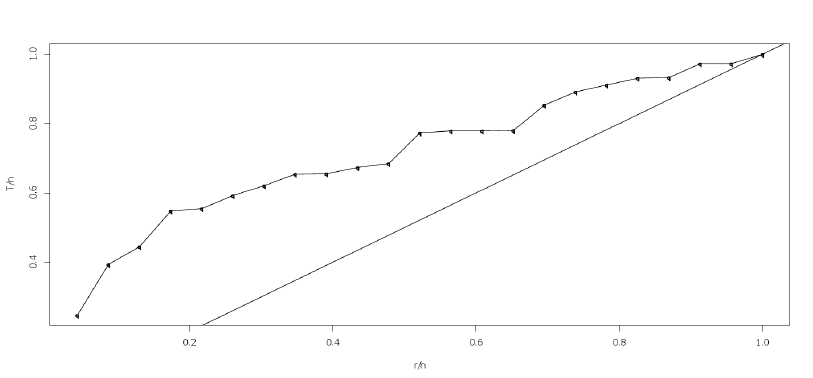
Figure 4 – PP plot for endurance of deep groove ball bearings data.